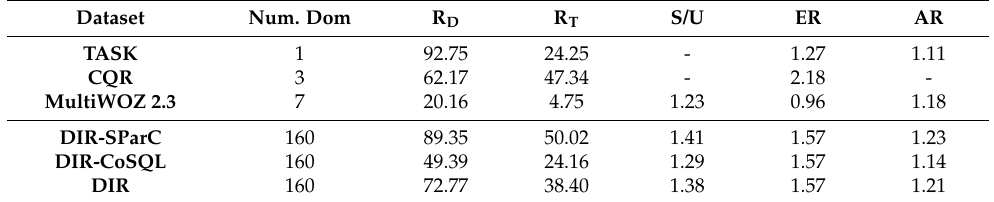
Table 2. Comparison of DIR and other analogous dialogue rewrite datasets. DIR-SParC and DIR- CoSQL are the two parts of DIR, split according to the data source. Num. Dom refers to the number of domains. R D refers to the ratio of the dialogue with at least one semantic incomplete utterance. R T refers to the ratio of semantic incomplete utterances. S/U , ER and AR are introduced in Section 4.3. Dataset Num. Dom